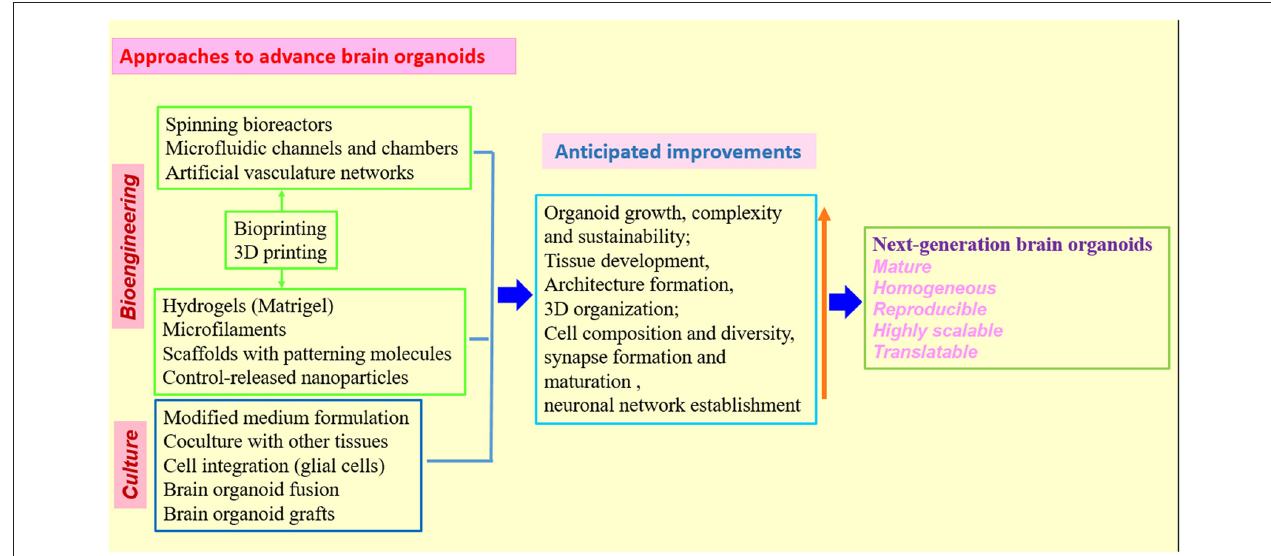
FIGURE 3 | Strategies and approaches to optimize human brain organoid models. Combination of biomaterials, bioengineering approaches with improved 3D culture techniques will be needed to create the next generation of human brain organoid models (Kelava and Lancaster, 2016a,b; Qian et al., 2016; Yin et al.,